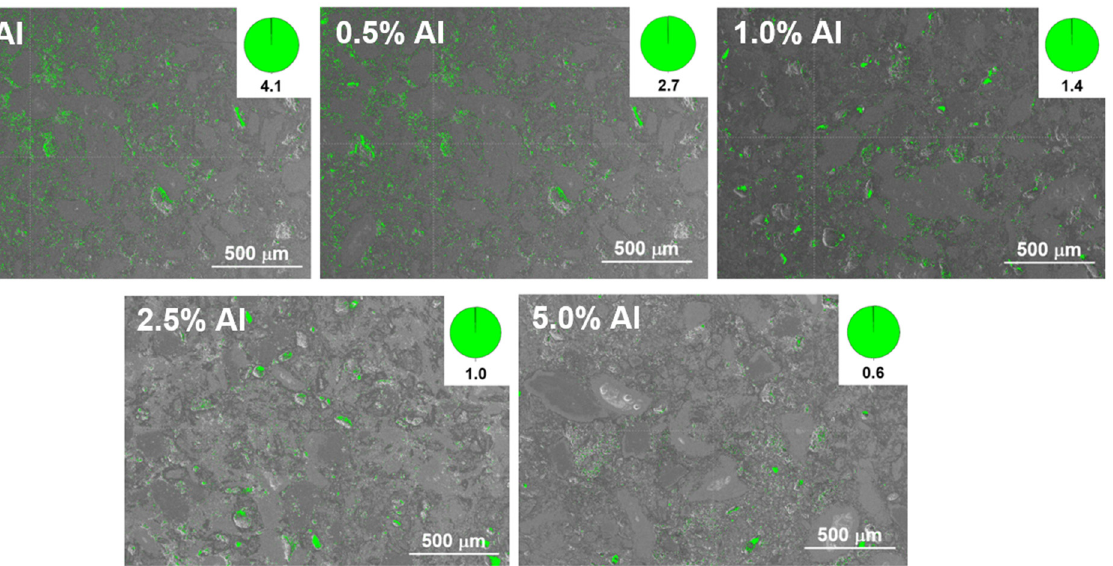
Figure 2. Microhardness results in Vickers scale (average and standard deviation) and lattice con- stant of the CrCuFeNiTiAl x alloy, both presented as a function of aluminum content.